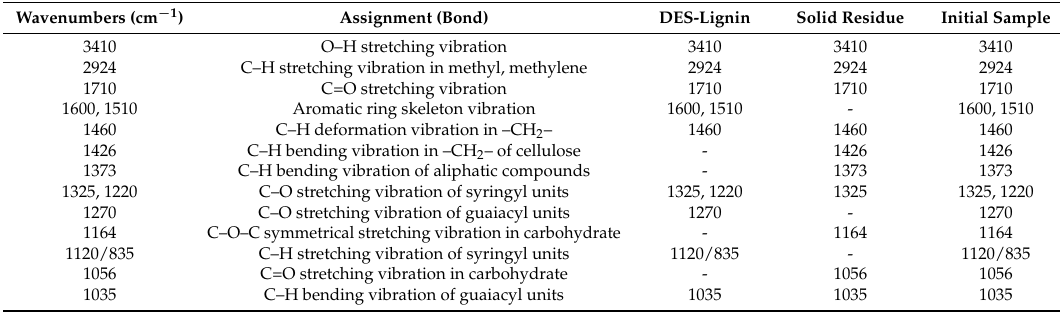
Table 3. Assignment of Fourier transform infrared spectroscopy (FT-IR)spectra of the initial sample, solid residue, and DES-Lignin.